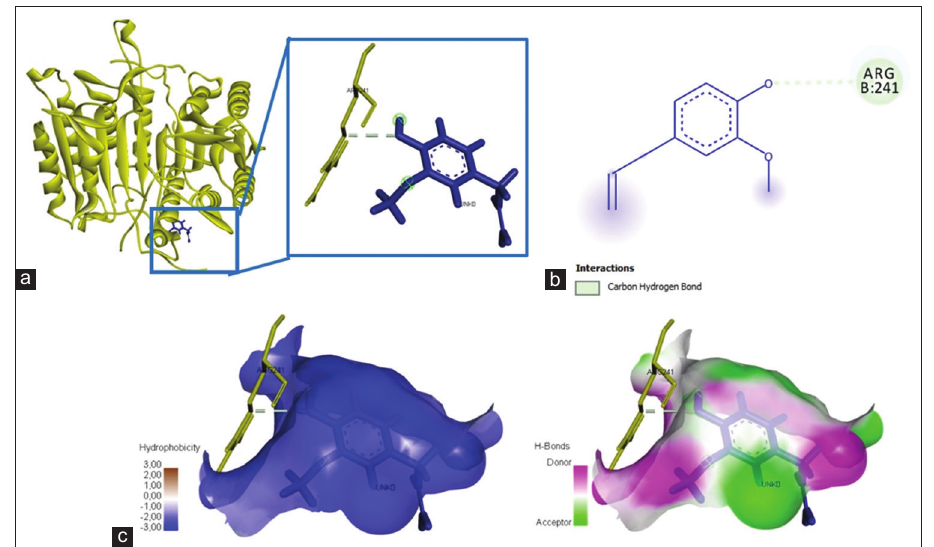
Figure-8: The visualization of the three-dimensional and two-dimensional interaction between phenolic compounds (eugenol) and caspase-3. (a) Three-dimensional structural interaction between the ligand eugenol (blue) and caspase-3 (yellow). (b) This interaction is established by hydrophobic hydrogen bonds on the active site of caspase-3, namely, Arg241, which is seen in the two-dimensional (b) and three-dimensional (c)